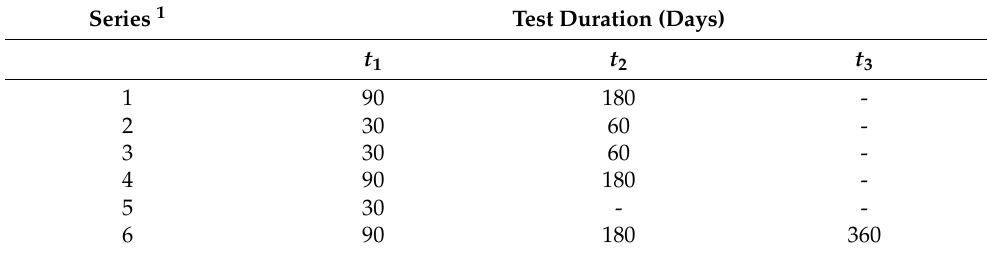
Table 5. Diffusion test duration of all of the test series.